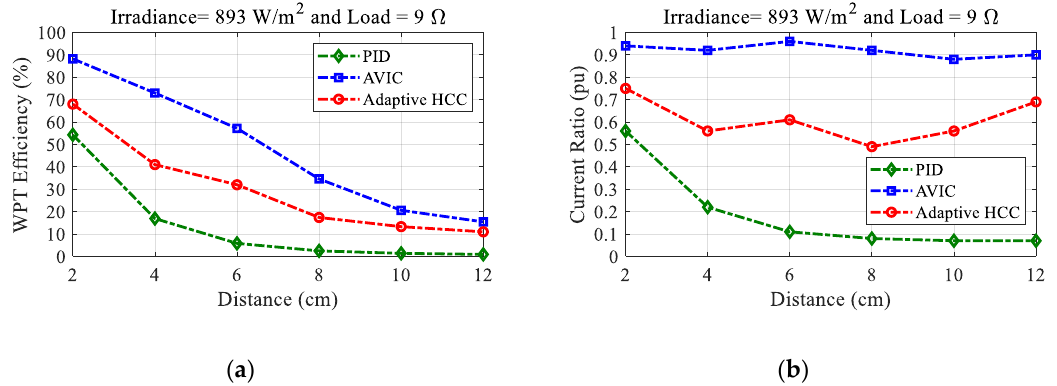
Figure 20. Performance evaluation at load of 0 Ω : ( a ) efficiency vs. distance, ( b ) current ratio vs. distance.